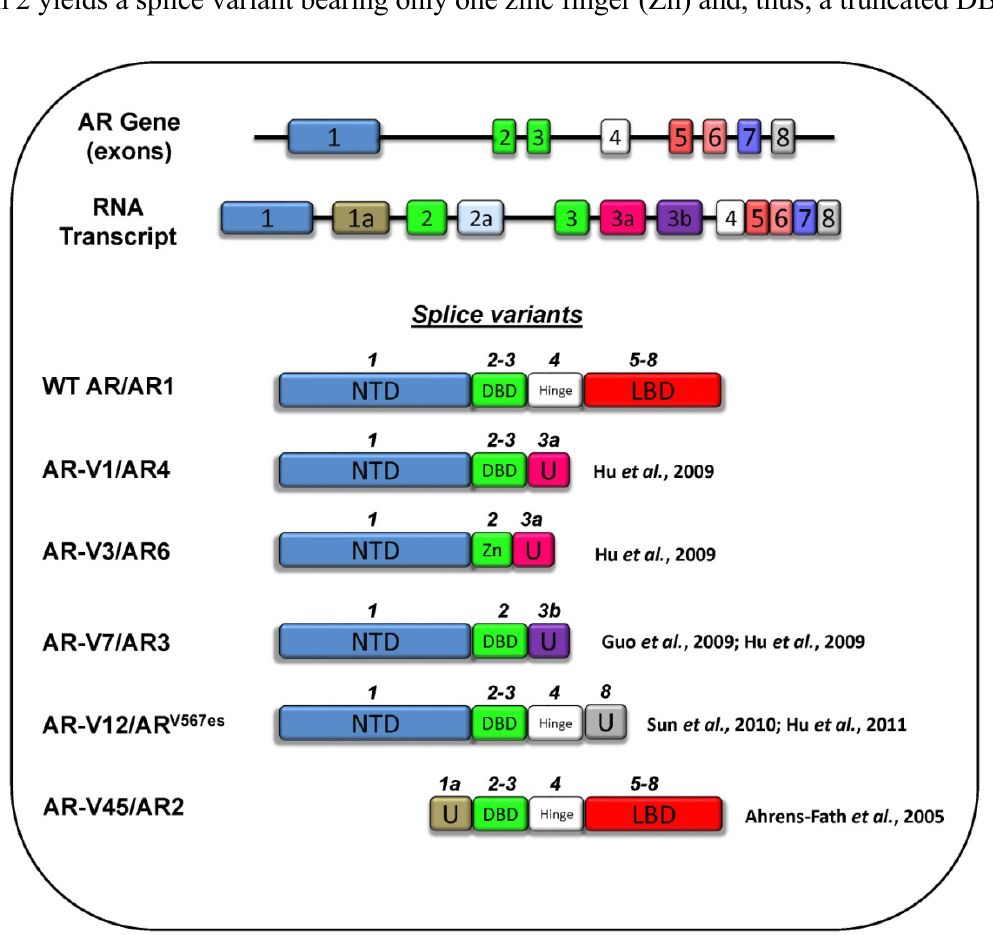
Figure 3. Common splice variants of the AR. The AR gene is organized as eight exons, which form the coding sequence for its different domains: NTD—exon 1; DBD—the first and second zinc finger motifs are encoded by exon 2 and 3, respectively; Hinge—exon 4; LBD—exons 5–8. The RNA transcript can by spliced in several ways to include combinations of the standard exons (numbered 1–8), as well as inclusion of cryptic exons (1a, 2a, 3a, 3b). Shown above each splice variant are the corresponding exon numbers included in spliced mRNA. Cryptic exon inclusion results in unique (U) regions with novel nucleic acid sequences not found in the wild-type (WT) AR. In AR-V3/AR6, the inclusion